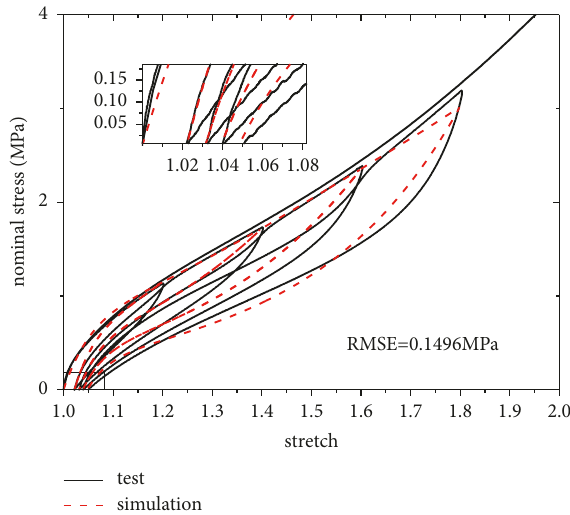
Figure 9: Experimental and simulation results of NSBR7 for the Mullins effect with the permanent